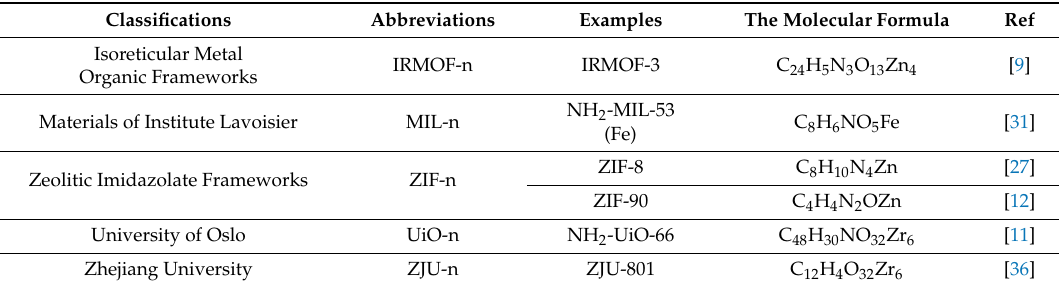
Table 2. The molecular formula of the metal organic frameworks (MOFs) that appear in this